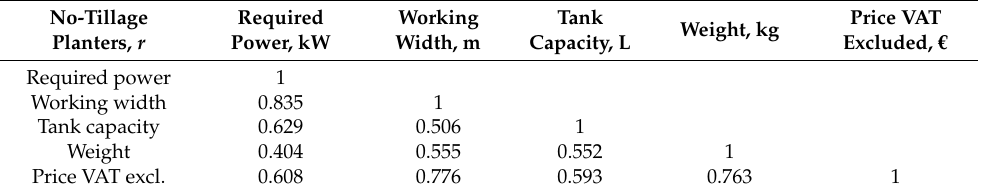
Table 7. Correlation matrix of Pearson coefficient r for functional parameters of no-tillage planters.